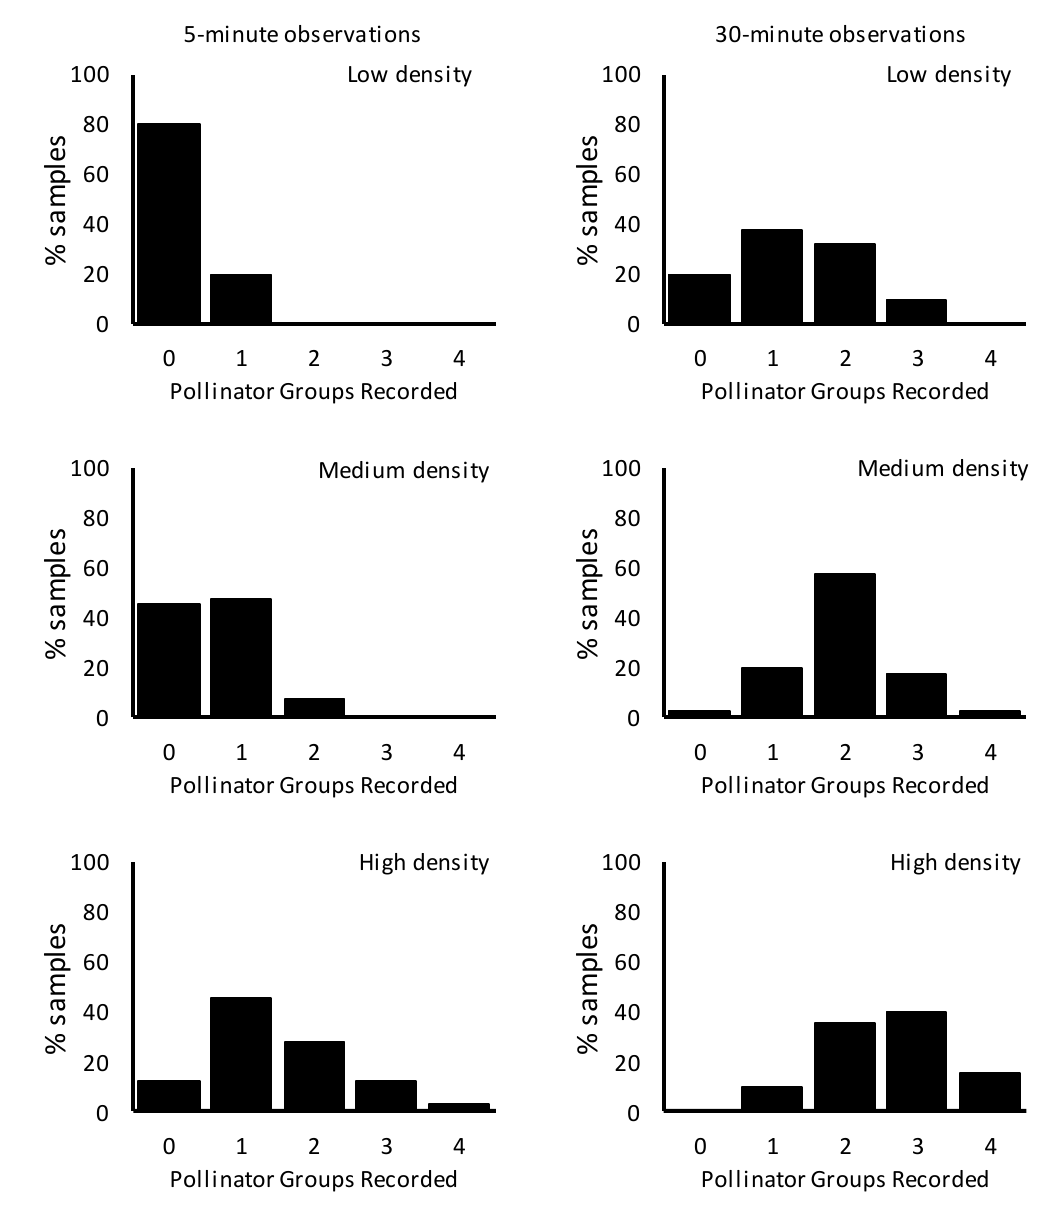
Figure 4. Number of pollinator groups ( Bombus spp., Apis mellifera , solitary bees, syrphids) recorded in 5-minute or 30-minute observation periods in 2 x 2 m plots classified as having low, medium, and high density of floral